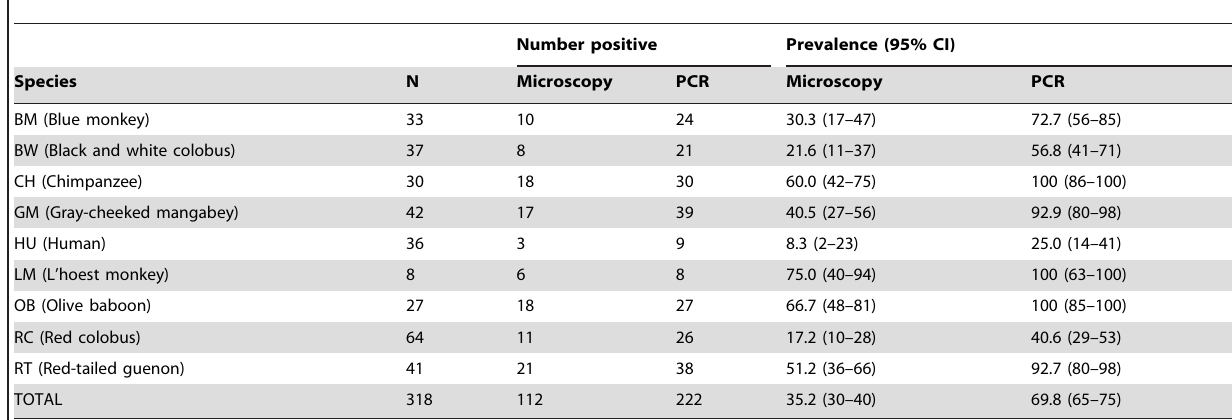
Table 1. Prevalence of Oesophagostomum spp. in nine primate host species (including humans) in and near Kibale National Park, Uganda, based on microscopy and